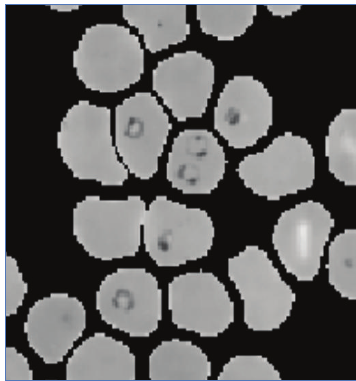
Figure 6: Gray scale converted image of object